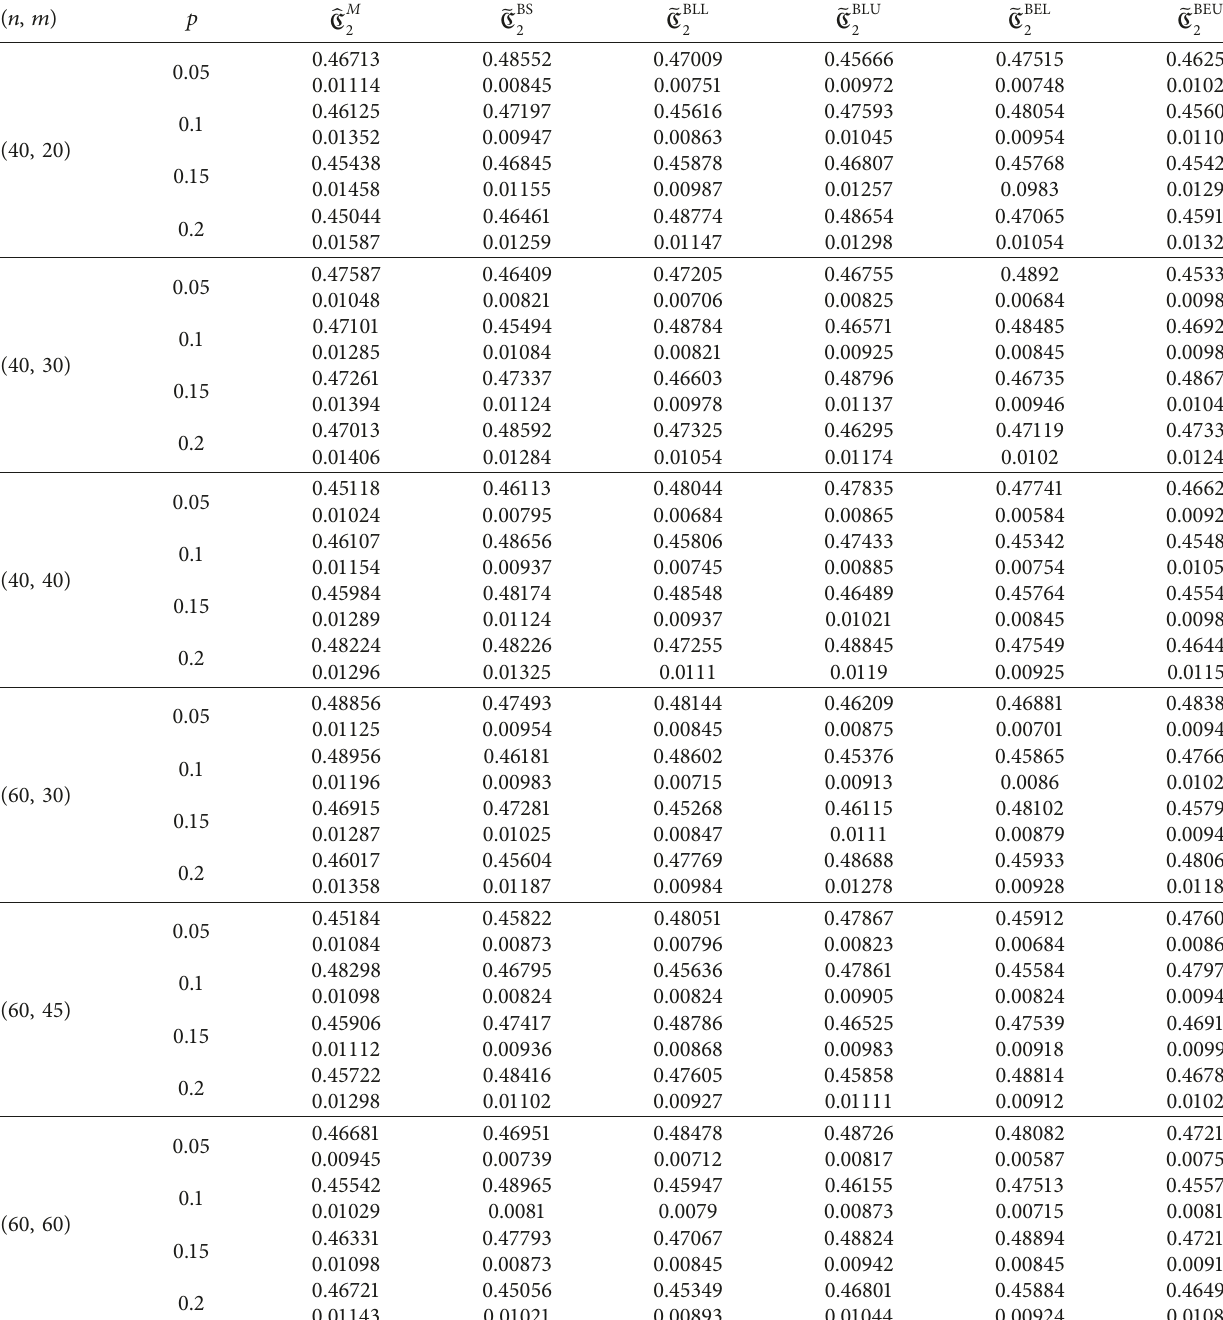
with respected MSE’s for different values of p and m for n 2